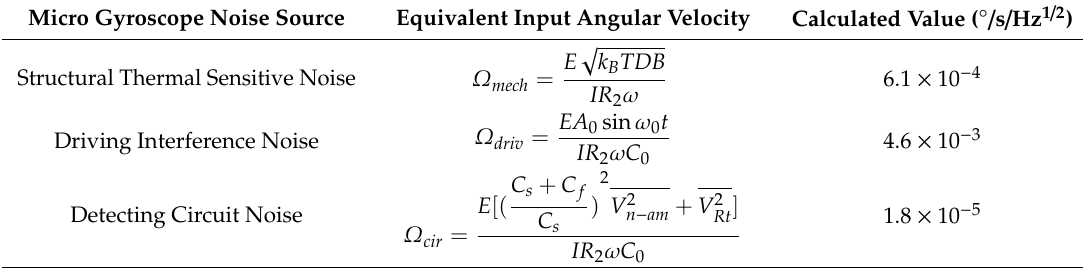
Table 1. Calculated values of equivalent input angular velocity noise of gyroscope